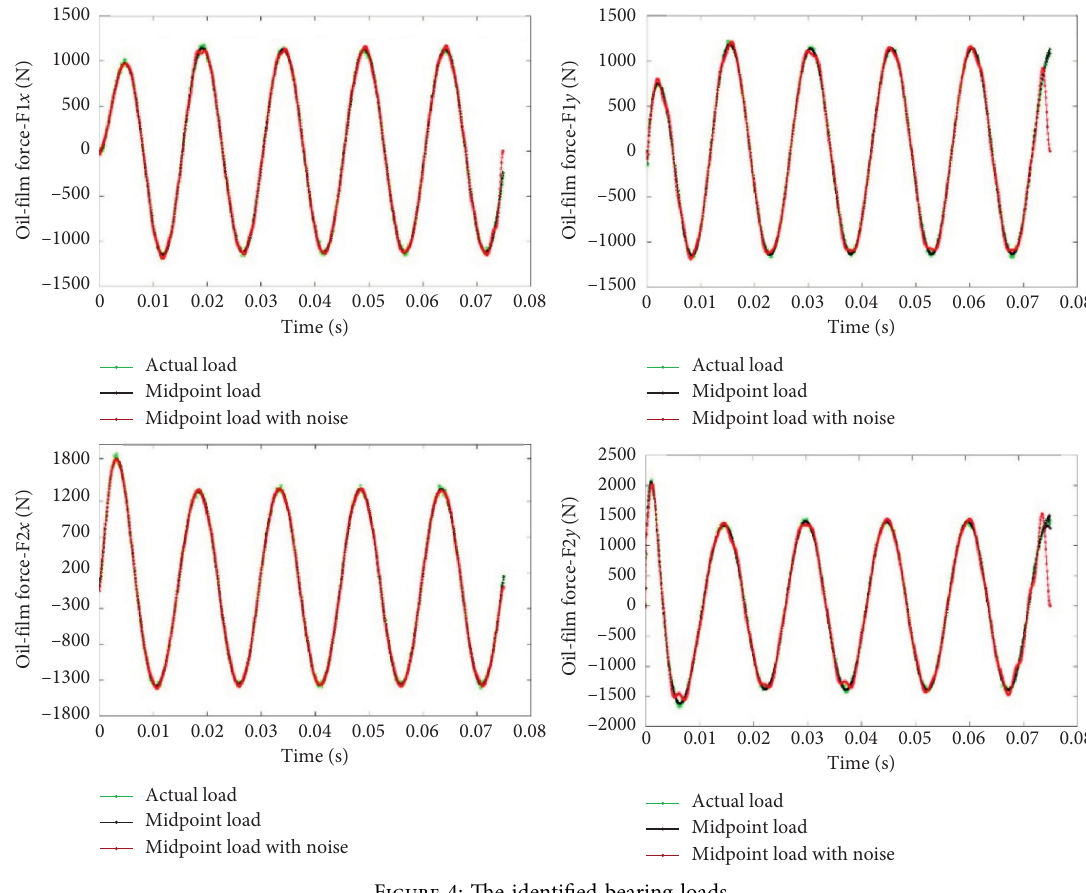
Figure 4: The identified bearing loads.